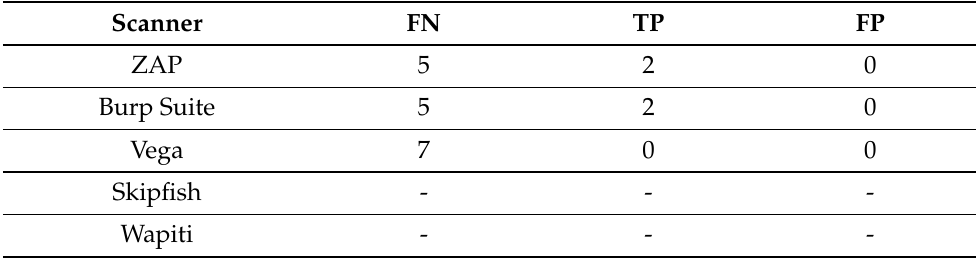
Table 7. FN, TP, and FP results in mode